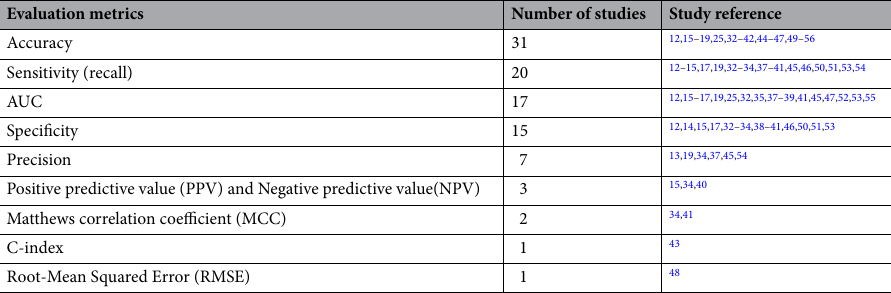
Table 6. The distribution of evaluation metrics in the included studies. The numbers in the second column do not sum up to 34 as many studies used more than a single